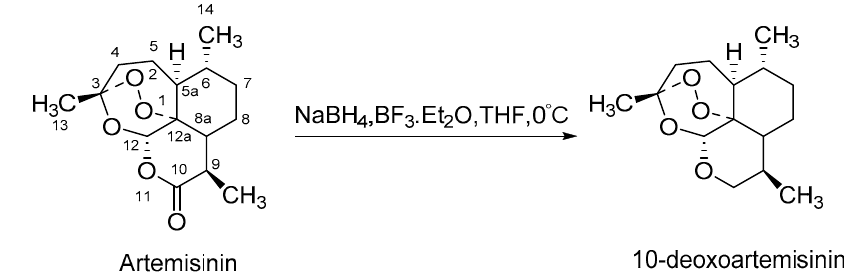
Figure 1. Scheme synthesis of 10-deoxoartemisinin.